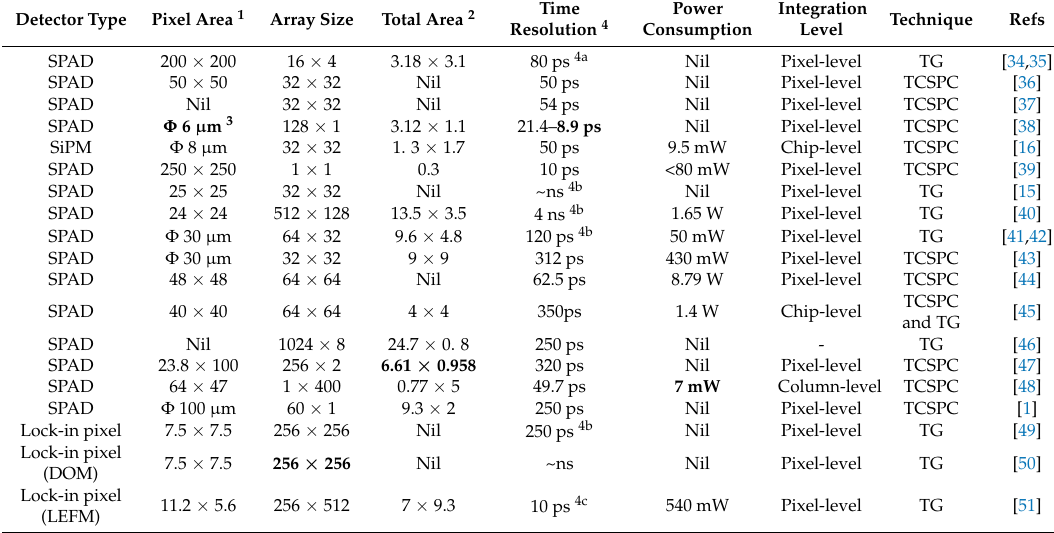
Table 1. Main parameters of several CMOS FLM microsystems including their single photon detector and photon counting module. The best merits for each option are in bold. TG stands for